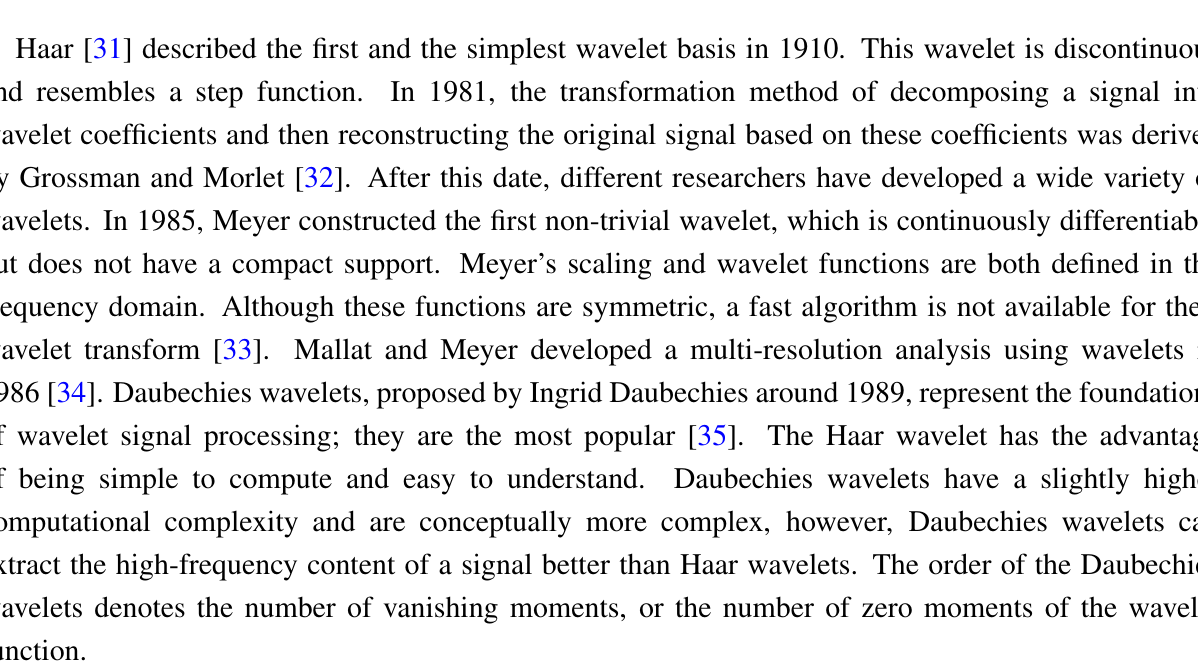
Table 4. Fundamental properties of the basic wavelet